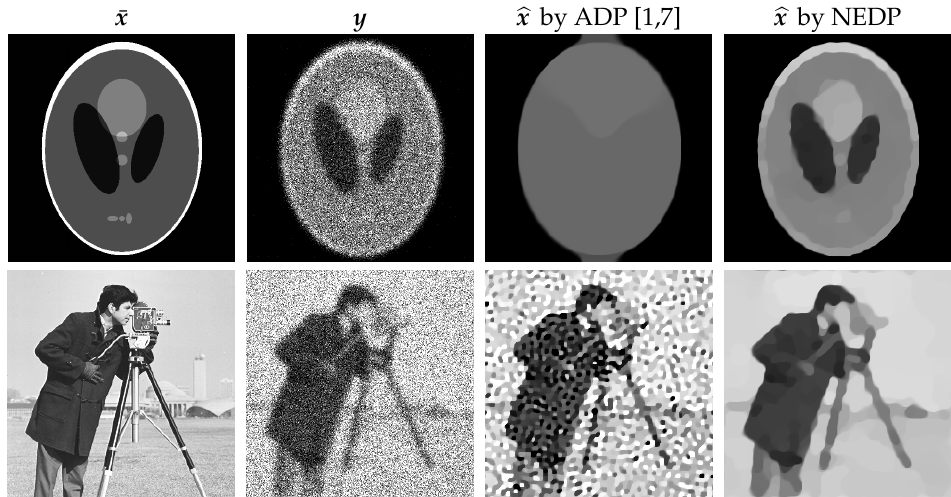
Figure 1. Original images ( first column), observed images corrupted by blur and Poisson noise ( second column), restored images obtained by the TV-KL model (8) and (9) with µ selected according to the approximate DP [5,7] ( third column), and the proposed nearly exact DP ( last column).